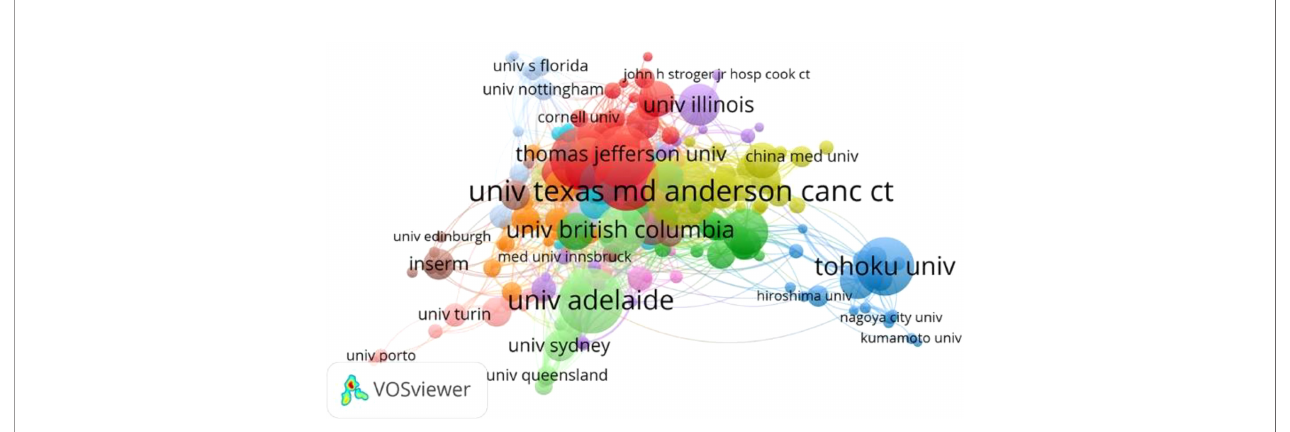
FIGURE 5 | Network map of co-authorship between organizations in this fi